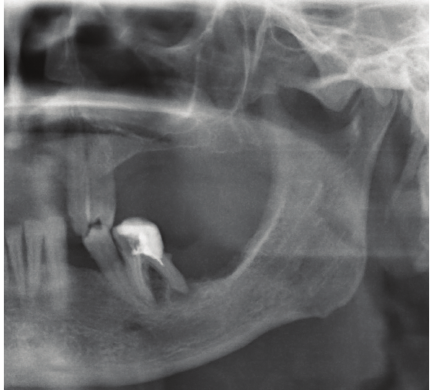
Figure 2: Case 1—the preoperative OPTG exhibits severe horizontal and vertical bone loss of the jaws. In addition, peri- and interradicu- lar osteolytic lesions around tooth 36 are present. A soft radiopacity as projection of the tumor mass can be identified along the intact alveolar crest distal of 36. Radiolucency, suspect for bone invasion is solely present at the interradicular and distal aspect of the roots.